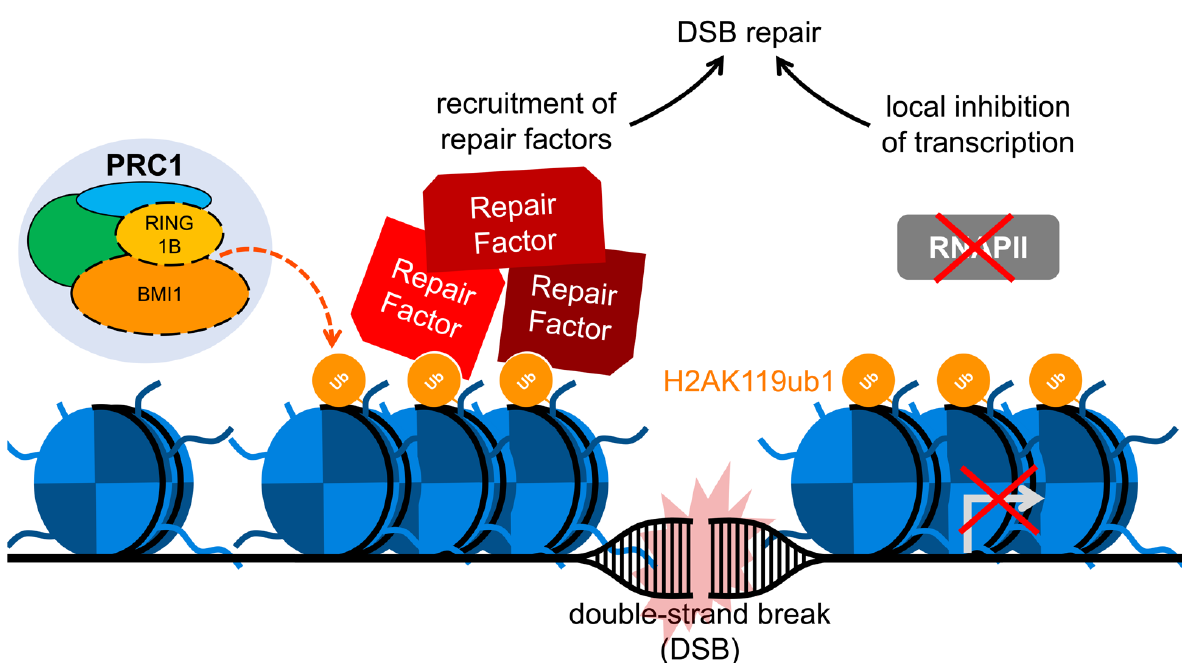
Figure 3. PRC1 in double-strand break repair. Double-strand break (DSB)-induced chromatin condensation upon ubiquitylation of histone H2A at K119 via the BMI1/RING1B E3 ubiquitin ligase component of PRC1. K119-monoubiquitylated H2A promotes the recruitment of repair factors as well as local transcriptional repression, both of which facilitate repair of the DSB.